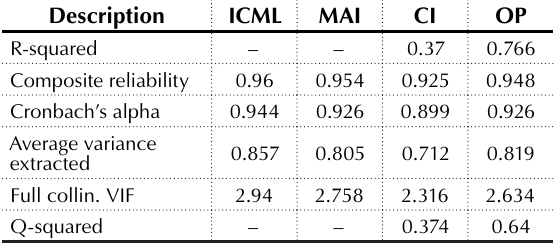
Table 4. Latent variable